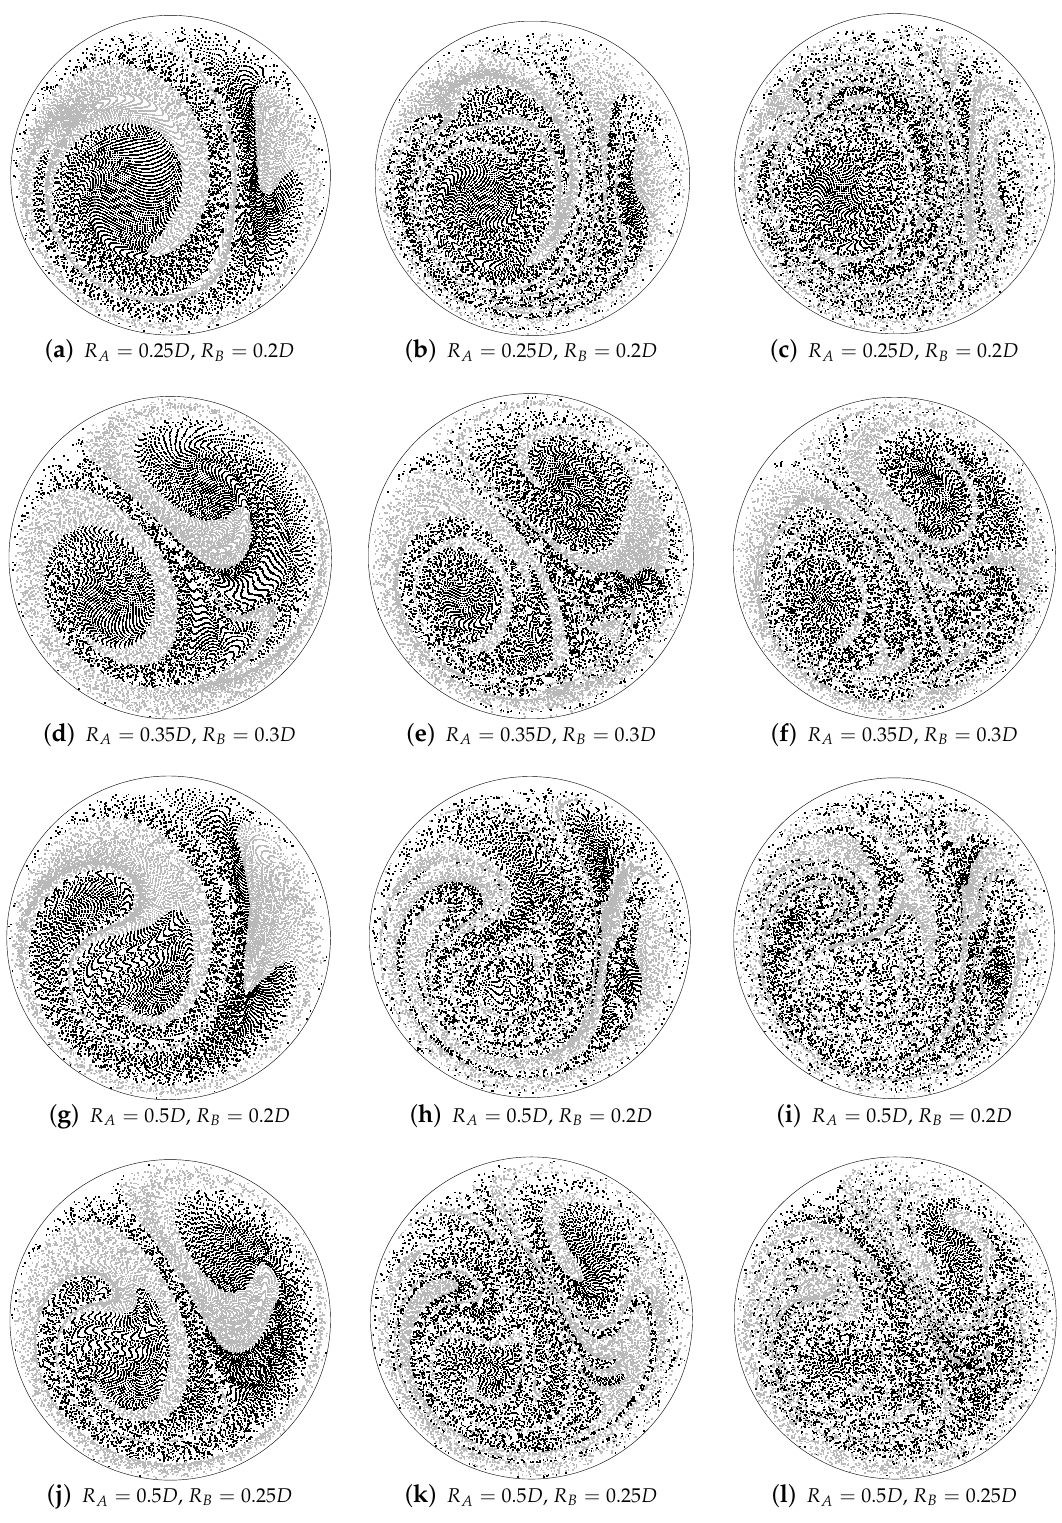
Figure 6. Slices of particle trajectories taken at z = 12 D ( left ), z = 24 D ( middle ), and z = 36 D ( right ) for the four combined helical geometries. For cases with only a small change in velocity fields the flow structures are still visible in the particle trajectory slices. However when this change is larger, ( g – i ) and ( j – l ), these structures are much less persistent at z = 36 D